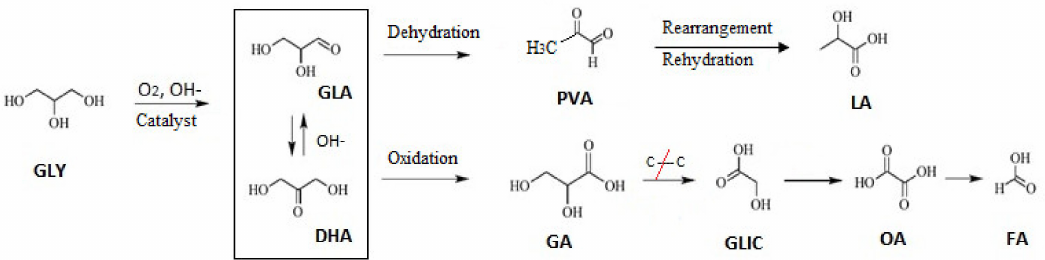
Figure 7. Scheme of reaction pathways for GLY